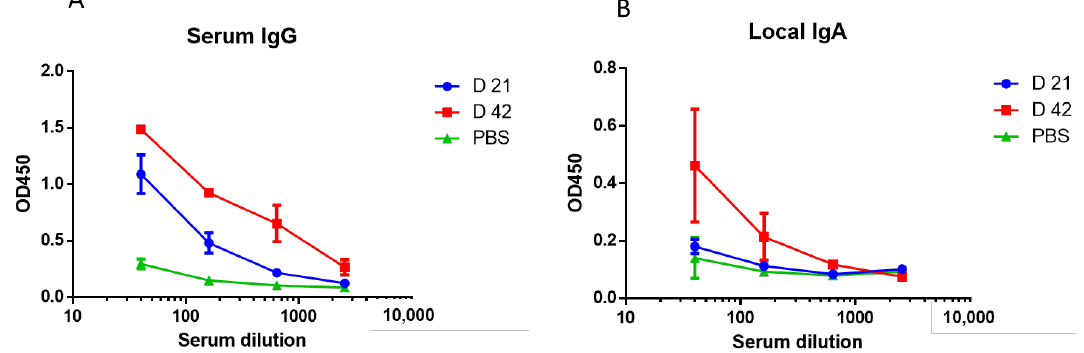
Figure 5. Antibody response to A/South Africa/3626/13(H1N1)pdm09 influenza virus estimated by ELISA, three weeks on day 21 after 1st and 2nd doses of trivalent LAIV containing A/17/New York/15/5364(H1N1)pdm09 ( n = 6). ( A ) Serum IgG. ( B ) Local IgA. It was shown that immunization with trivalent LAIV significantly protected mice from sequential influenza A/H1N1pdm09 and pneumococcal infections, when pneumococcal infection was induced on day three after primary influenza infection (Figure 6).